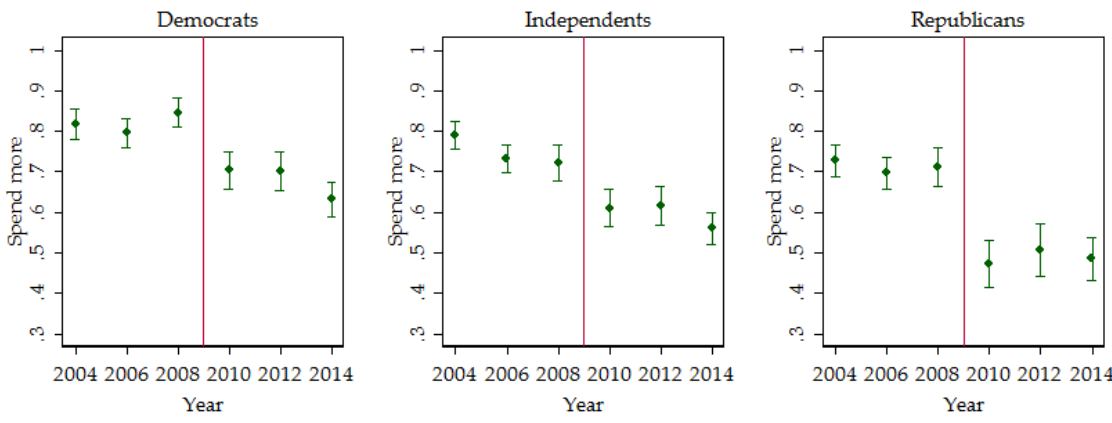
Figure 3: Background and ideology-adjusted proportion of respondents, by party identification, who indicate that “too little” money is spent on the nation’s